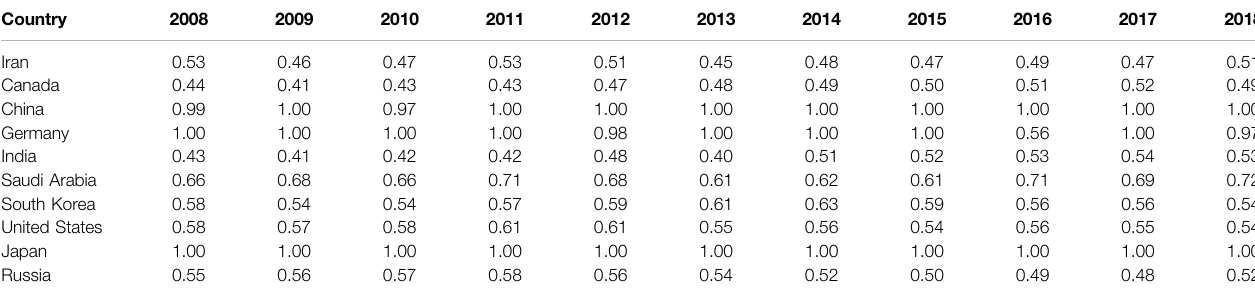
TABLE 7 | Ef fi ciency of CO 2 emission for top 10 CO 2 emitter countries.